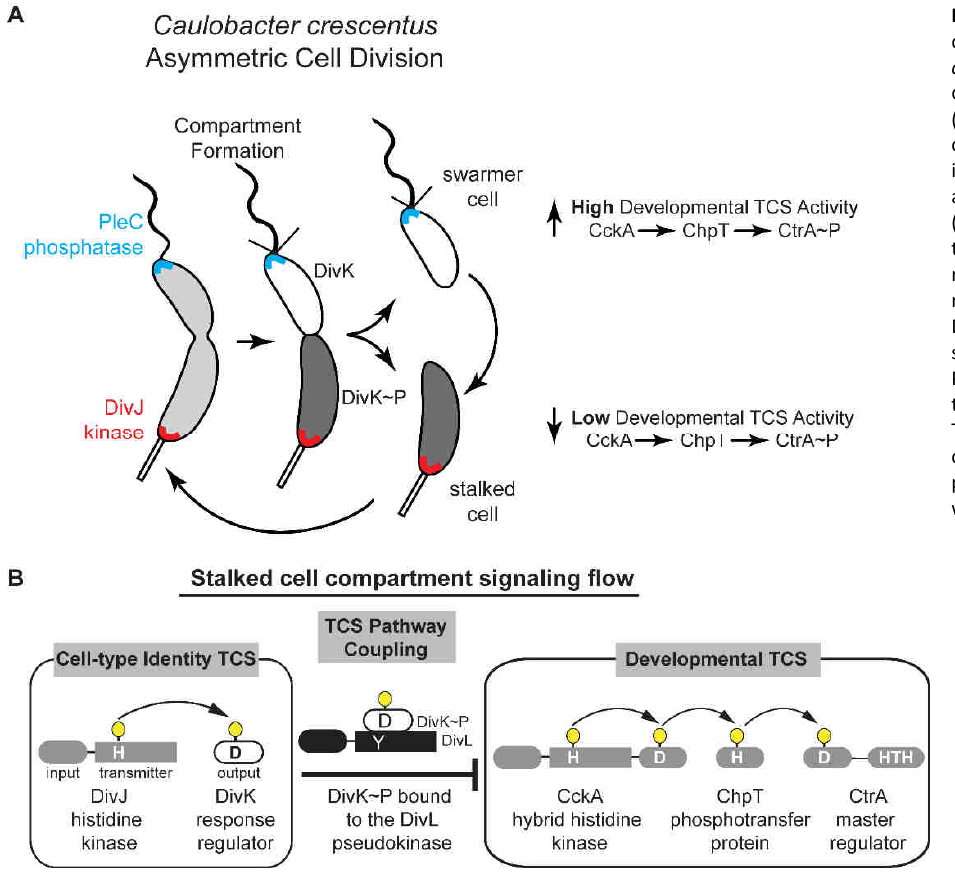
FIGURE 1: (A) Asymmetric cell division in Caulobacter cres- centus is driven by a single- domain response regulator (DivK~P, shaded gray within cell cartoons) that has been inversely correlated with the activity of a cell-cycle kinase (CckA) that in turn activates the CtrA transcription factor regulating over 100 develop- mental genes. (B) The kinase DivJ phosphorylates DivK in the stalked compartment, while PleC dephosphorylates DivK in the swarmer compartment. The pseudokinase DivL forms a